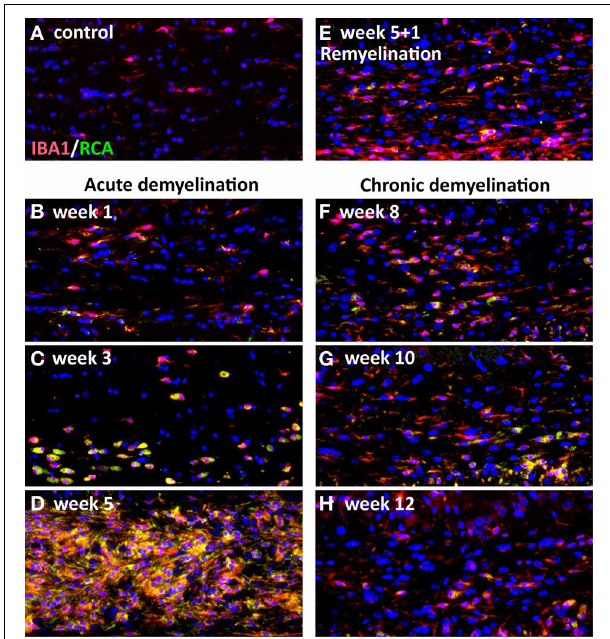
FIGURE 2 | Activation of microglia during the course of cuprizone-induced demyelination (acute and chronic). Representative coronal sections from the medial corpus callosum were stained with the microglial marker IBA-1 (general microglial marker) and RCA-1, which stained activated microglia. There are no activated, RCA-1-positive microglia in control mice (A) . Activated microglia could be detected in the medial corpus callosum already after 1 week of cuprizone feeding (B) . After 3 weeks of cuprizone feeding activated microglia begin to accumulate in the corpus callosum (C) . The amount of activated microglia increases upon the course of demyelination and reaches its maximum after 5 weeks of cuprizone treatment (D) . If cuprizone is stopped after 5 weeks microglia numbers begin to decline with the onset of remyelination at week 6 (5 + 1 week) (E) . If cuprizone was fed further on to induce a chronic demyelination a small amount of activated microglia persists until week 12 (F–H)